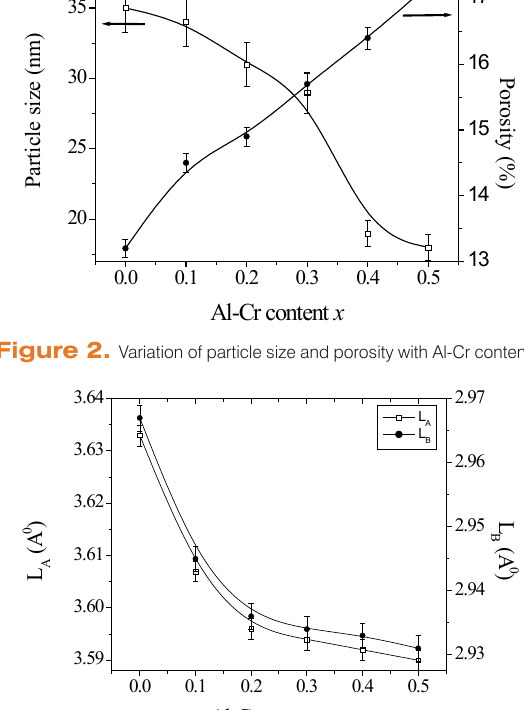
and L with Al-Cr content A B